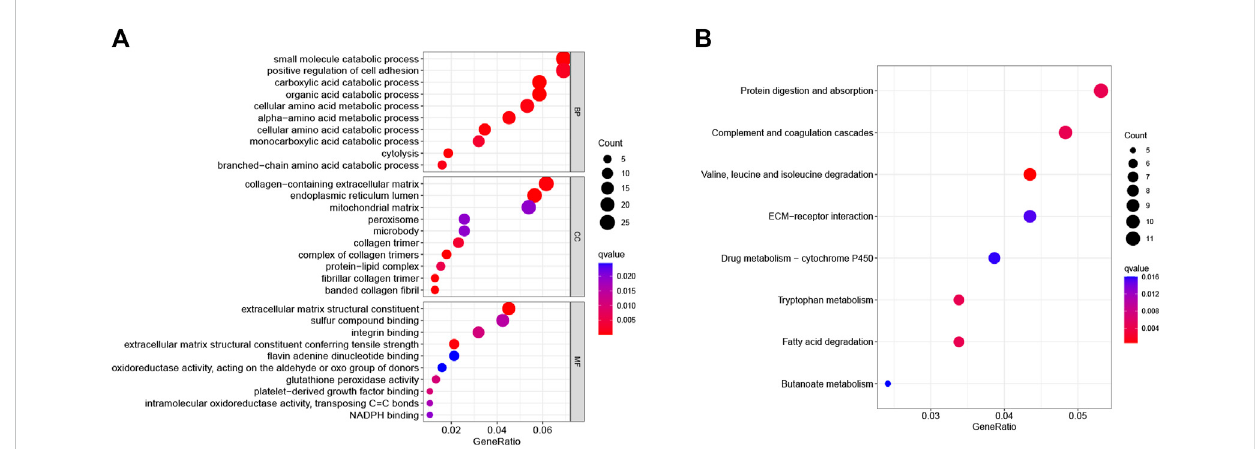
FIGURE 2 GO and KEGG pathway analyses of common DEGs. (A) The top ten GO functional enrichment analyses of the common DEGs in biological process (BP), cell composition (CC), and molecular function (MF) groups, respectively. The bubble size in the dotplot shows the fi rst fi ve terms, and the size represents p-adjusted values for these terms. (B) The top eight signi fi cant KEGG signal pathways of the common